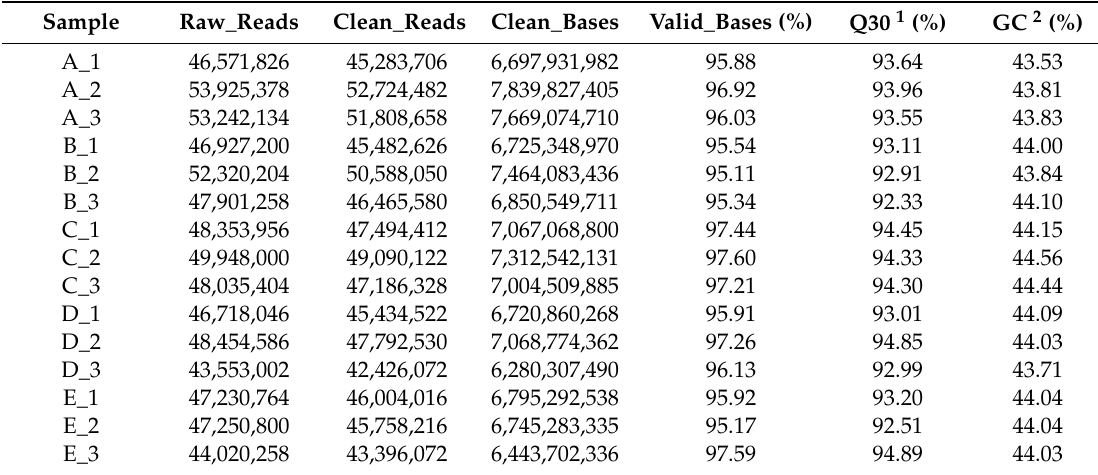
Table 1. Statistics of sequencing